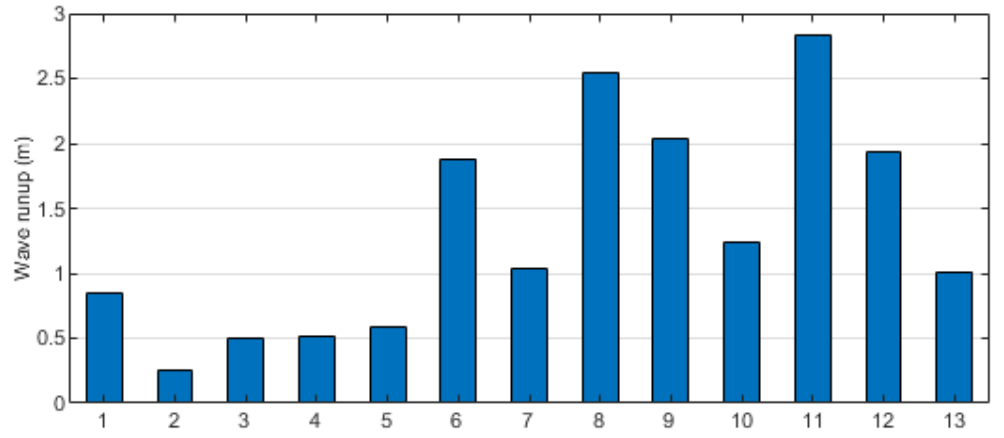
Figure 7. Wave run-up for the 50-year period at the 13 measuring points along the levee.